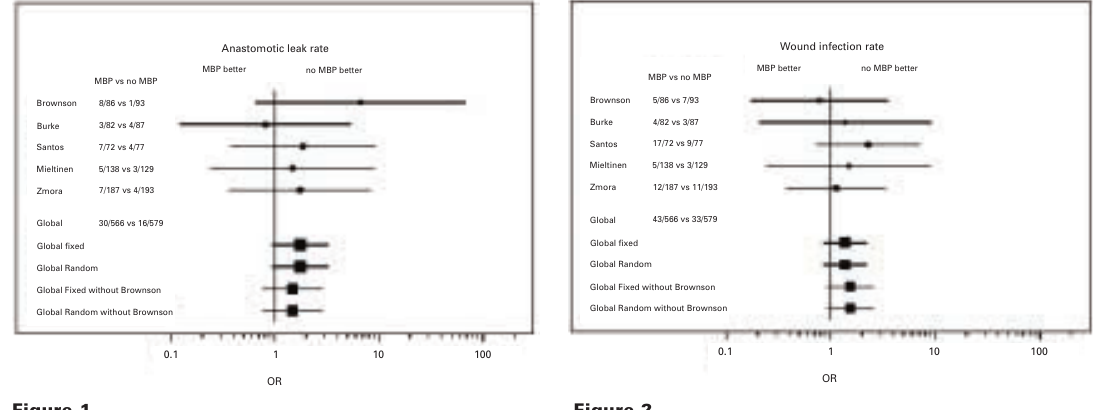
Figure 2 Wound infection rate (odds ratio >1 favours No MBP).